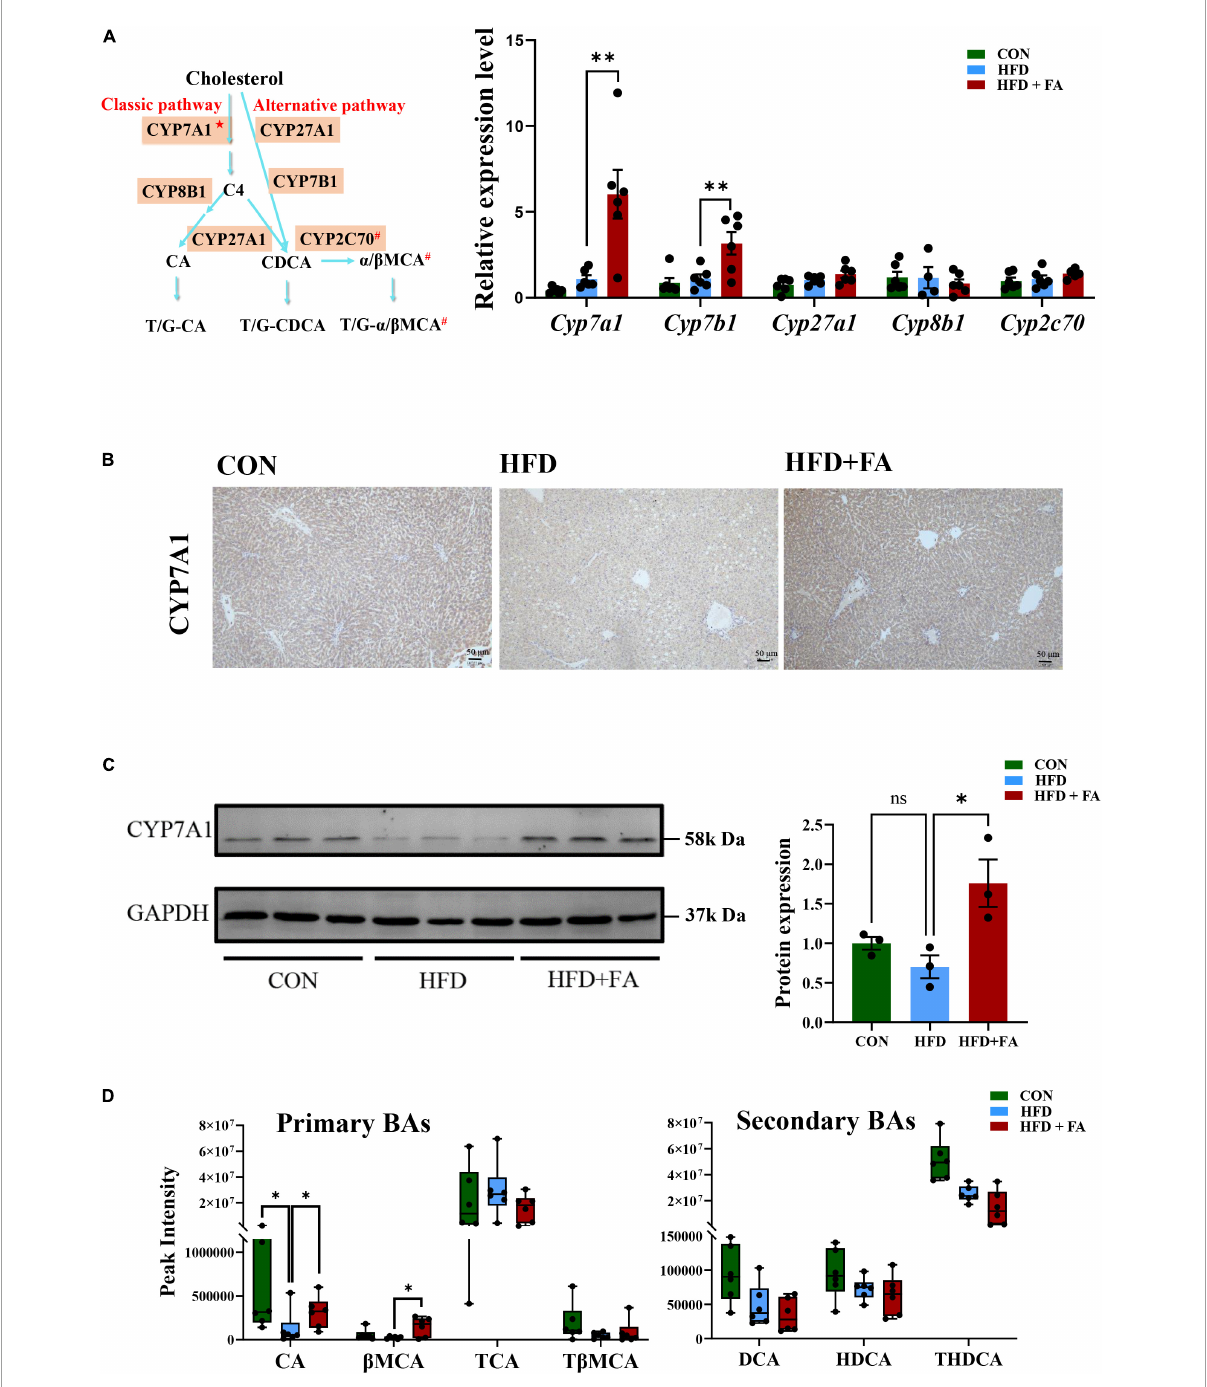
FIGURE3 FA increases bile acid biosynthesis in the liver. (A) Schematic representation of synthetic pathways of primary BAs (left) and the mRNA levels of 5 key genes involved in the BAs biosynthesis including Cyp7a1 , Cyp7b1 , Cyp27a1 , Cyp8b1, and Cyp2c70 (right) in the livers of the CON, HFD and HFD + FA mice ( n = 6). The relative mRNA levels were analyzed referring to the 2- (cid:49)(cid:49) CT method and normalized to the Actb gene. C4: 7 α -hydroxy-4-cholesten-3-one; CA: cholic acid; CDCA: chenodeoxycholic acid; α / β MCA: α / β - muricholic acid; (cid:70) The rate-limiting enzyme in BAs biosynthesis; # Only in mice. (B) Representative images showing IHC staining of CYP7A1 protein in the livers of the CON, HFD and HFD + FA mice. Scale bar, 50 µ m. (C) Western blot analysis of hepatic CYP7A1 protein in the CON, HFD, and HFD + FA mice (left, n = 3), and quantification analysis using ImageJ (right). (D) Relative levels of 7 primary and secondary BAs (CA, β MCA, TCA, T β MCA, DCA, HDCA, THDCA) identified in the livers of the CON, HFD, and HFD + FA mice ( n = 6). Data are presented as mean ± SEM. ∗ p < 0.05, ∗∗ p < 0.01, ns, no significance vs. HFD group. CON, control diet group; HFD, high-fat diet group; HFD + FA, high-fat diet with 100 mg/kg bw/day FA